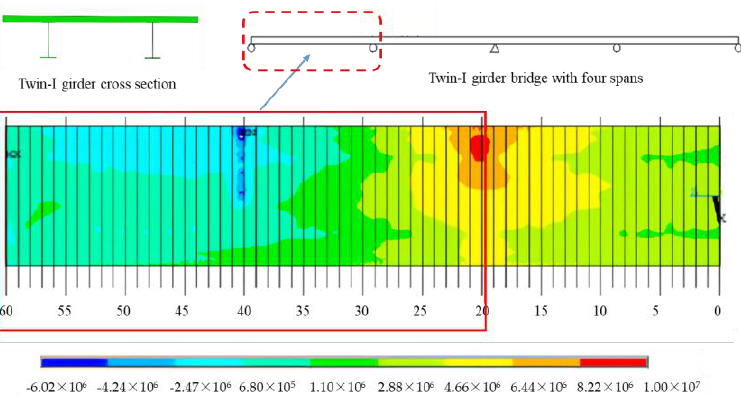
Figure 2. Stress distribution in the concrete deck under the service limit state (unit: